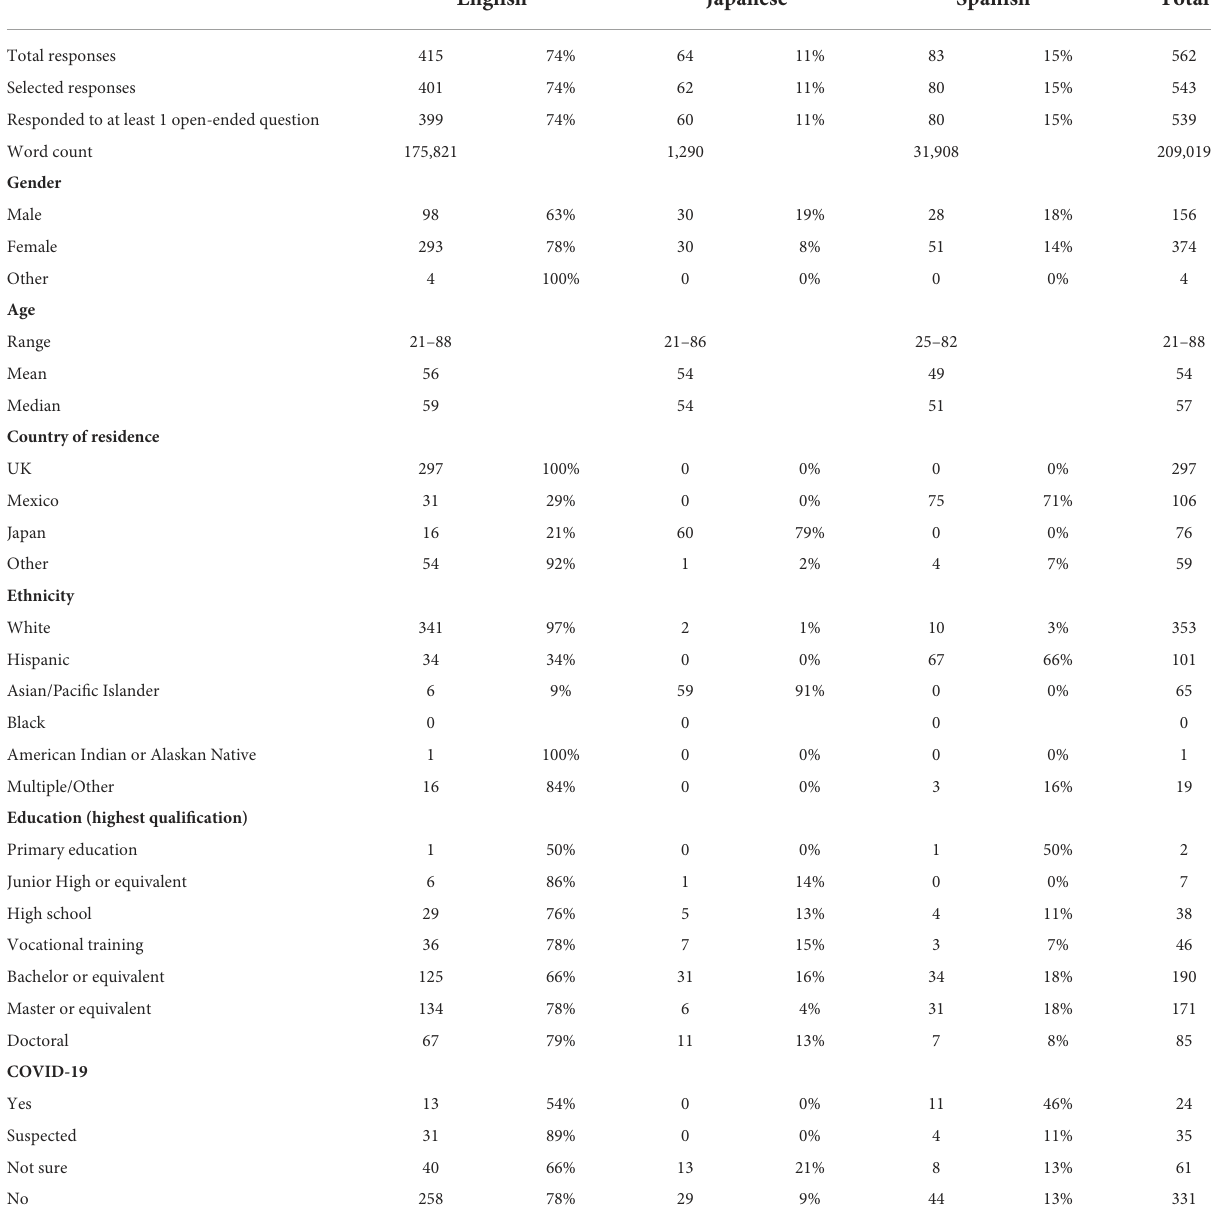
TABLE 1 Statistics and demographics of the pandemic experience corpus from survey II. English